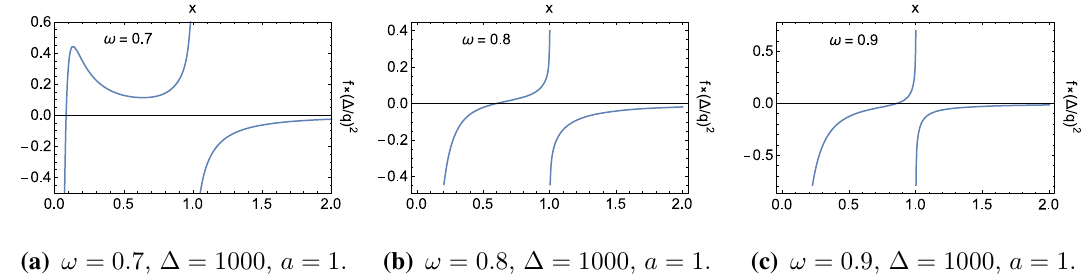
Fig. 1 Dimensionless self-force f × ((cid:14)/ q ) 2 in terms of the dimensionless coordinate x , for different values of the angle deficit parameter ω . The throat is at x = 0 and the exterior shell is at x = 1